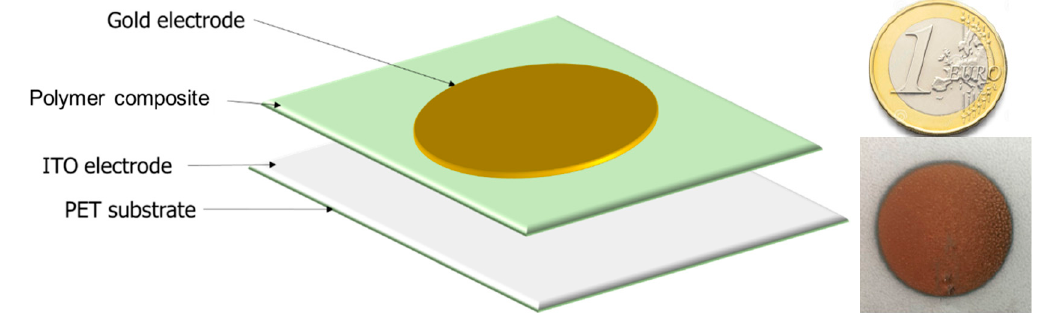
Figure 1. Structure of a flexible terpolymer/phosphor composite.